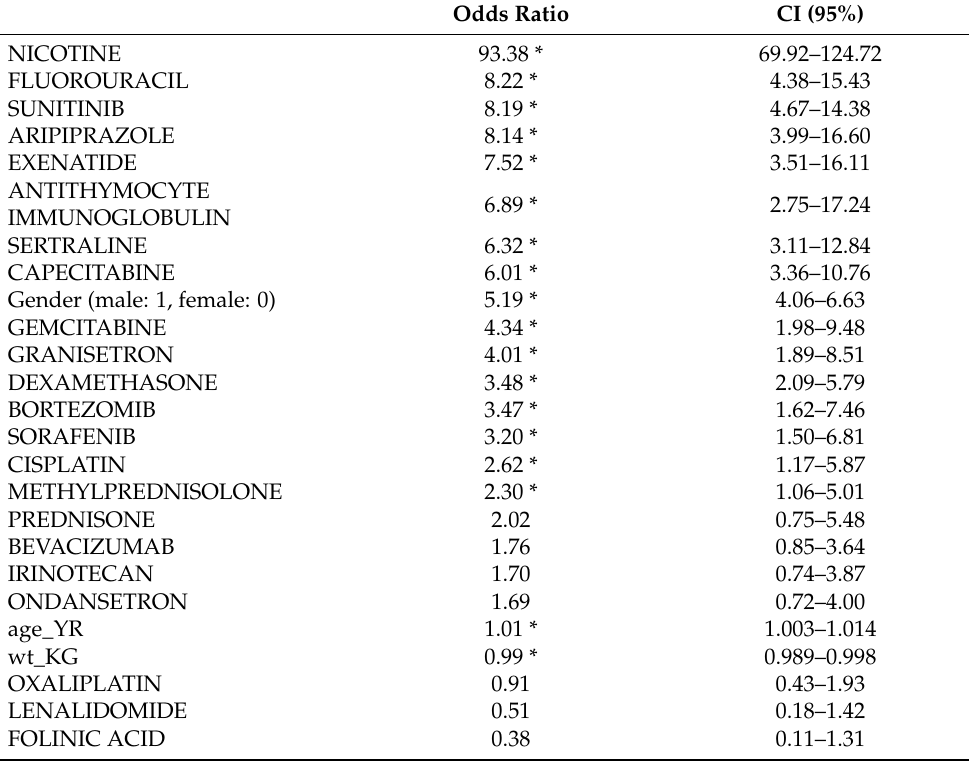
Table 2. Results of a multiple logistic